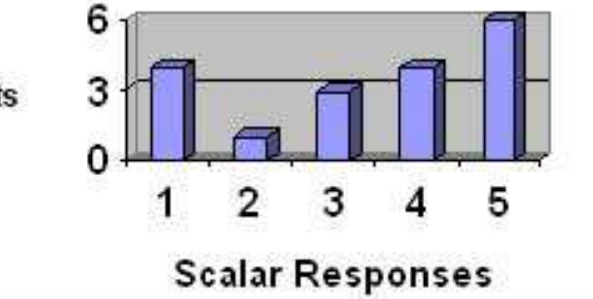
How important participants felt the issue of sexual orientation was in diversity trainings (n=18), Alachua County, Florida,